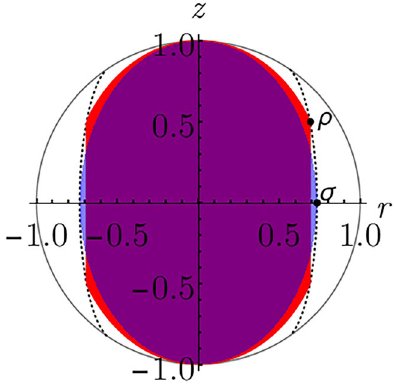
r plane. The black dots represent two qubit states: ρ (upper − 0.5 ) and σ (lower dot, with r 2 0.732828, z 2 0 ). The red and blue regions = = = r plane, respectively. The dotted ρ ′ ρ ρ ′ ρ ′ σ ρ ′ and on the z { : → IO } { : → IO } − C r plane. From the figure, it can be 0.3 ρ ′ projected on the z re (ρ ′ ) { : = } − C 0.3 re (σ) = =